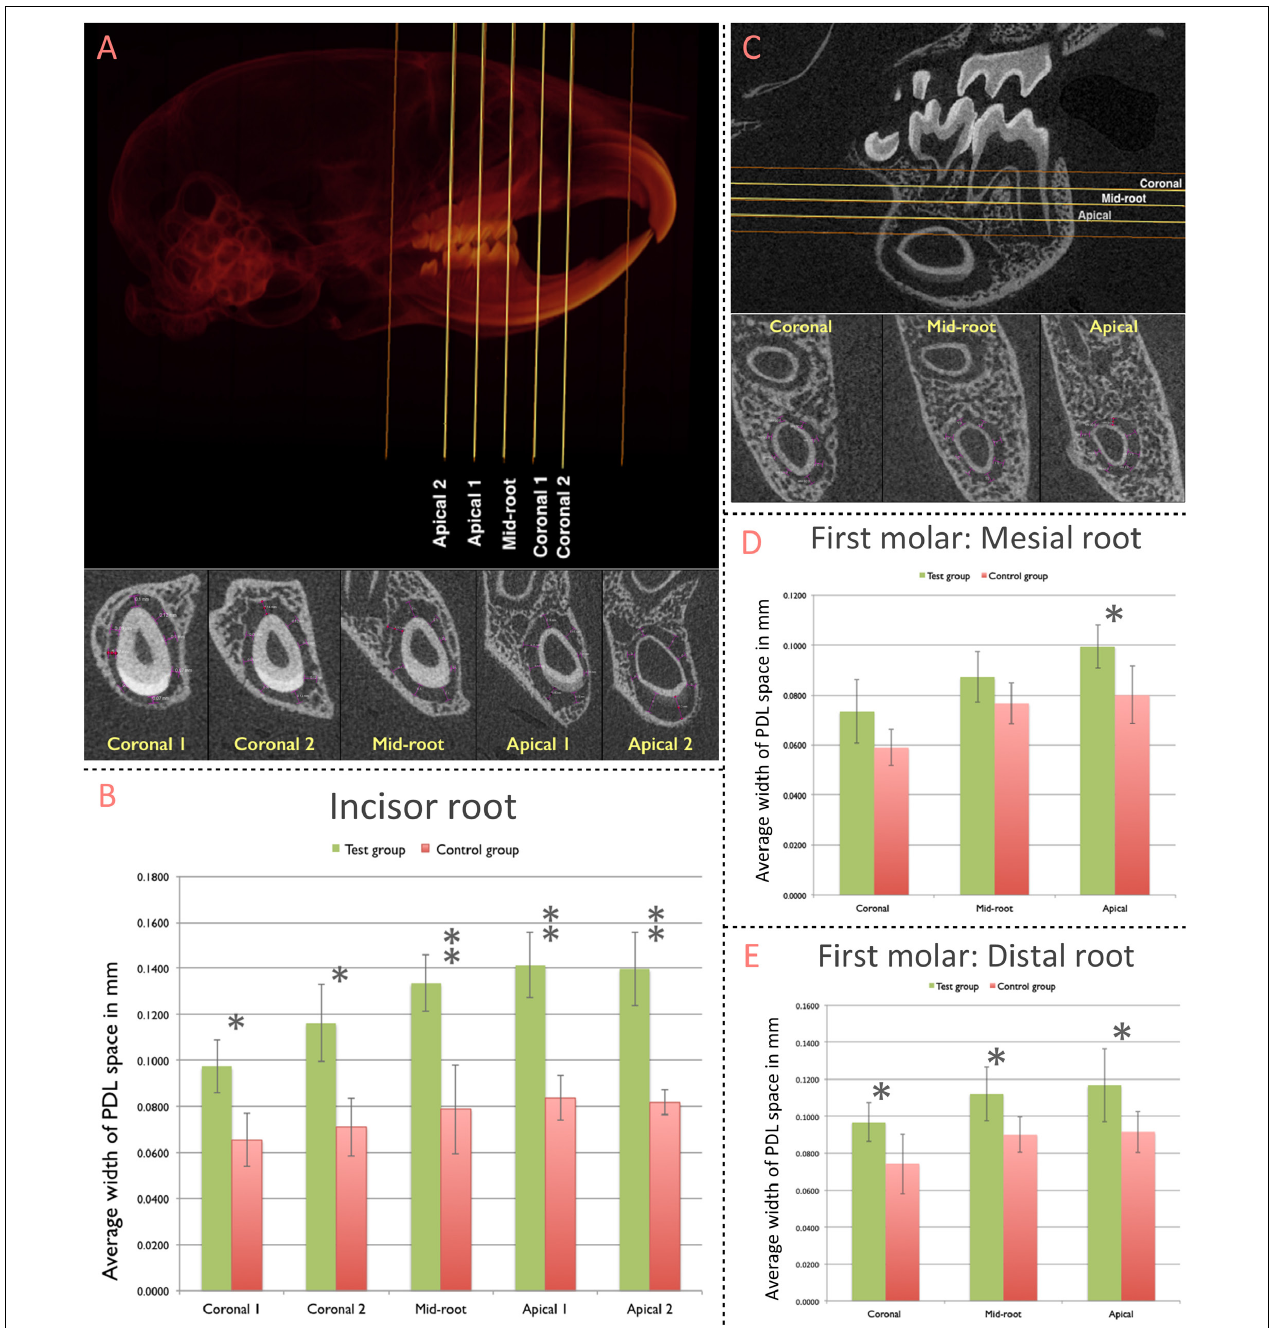
FIGURE 3 | Contribution of pnPRX1 + cells to the post-natal development of the molar and incisor periodontium. (A) The width of PDL space around the root of the right mandibular incisor was measured in five transverse slices (Coronal 1, Coronal 2, Mid-root, Apical 1, and Apical 2 slices; top image). These transverse slices were generated based on the two indicated reference points (orange lines): the most coronal level of the alveolar bone (coronal reference) and the most apical point of the tooth socket (apical reference). The linear measurements of the width of PDL space were performed at 8 different points within each section (bottom image, purple arrows). The measurements at the enamel surface (buccal measurement in the most of slices) were excluded from the analysis. All 8 linear measurements were averaged and such average was considered as the width of the PDL space for each section. (B) Comparison of the width of PDL space of the mandibular incisor tooth between the test and the control groups. (C) The width of the PDL space around mesial root of right mandibular first molars was measured in three transverse slices (Coronal, Mid-root, and Apical - yellow lines) generated based on two reference points (orange lines): the furcation entrance of the tooth (coronal reference) and the apex of the mesial root (apical reference). Similar methodology was used to select the slices for the distal root of the first molars. The linear measurement was performed at 8 different points, similarly, to what was performed for the incisor tooth. (D) Comparison of the width of PDL space of mesial root of the mandibular first molar; and (E) distal root of the mandibular first molar between test and control groups. ( ∗ p < 0.05, ∗∗ p < 0.001).